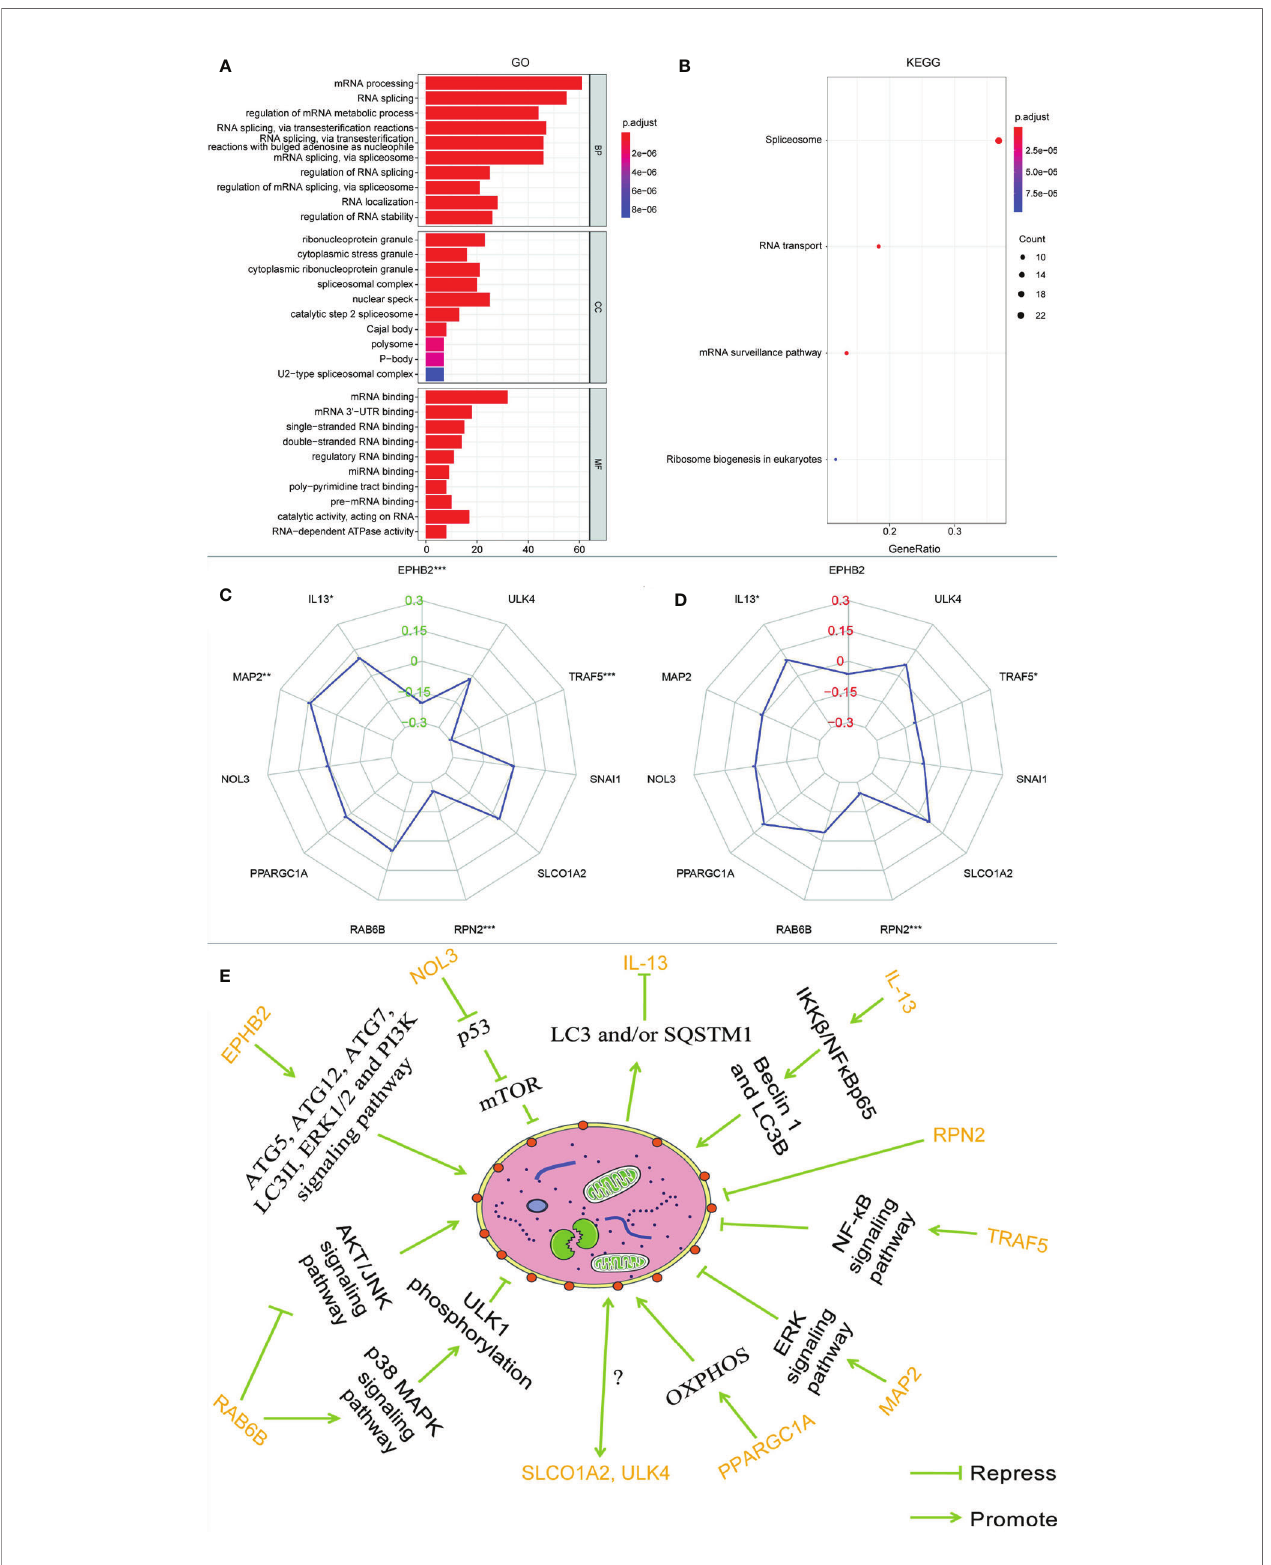
FIGURE 7 | (A) GO analysis and (B) KEGG analysis of the target genes of 11 autophagy-associated genes in the model. The radar maps of 11 autophagy- associated genes are analyzed with MSI (C) and TMB (D) , respectively. Regulatory relationships between the 11 genes in the model and autophagy (E) . * p < 0.05, ** p < 0.01, *** p <